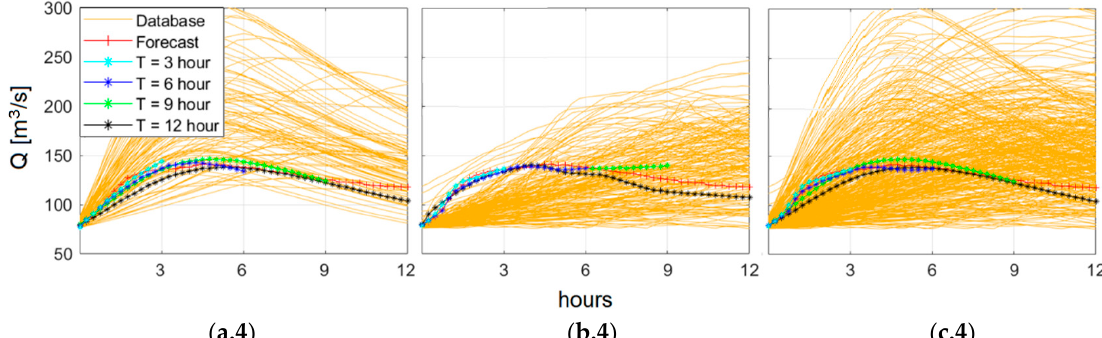
Figure 8. Comparison of runoff hydrographs at the virtual gauge for the event of May 2013 for SD ( a ), REBD ( b ), HD ( c ). The yellow lines represent the hydrographs of the offline database, the red line the runoff forecast, the light blue, blue, green, and black lines represent the selected offline hydrograph for the intervals of 3, 6, 9, and 12 h, respectively.